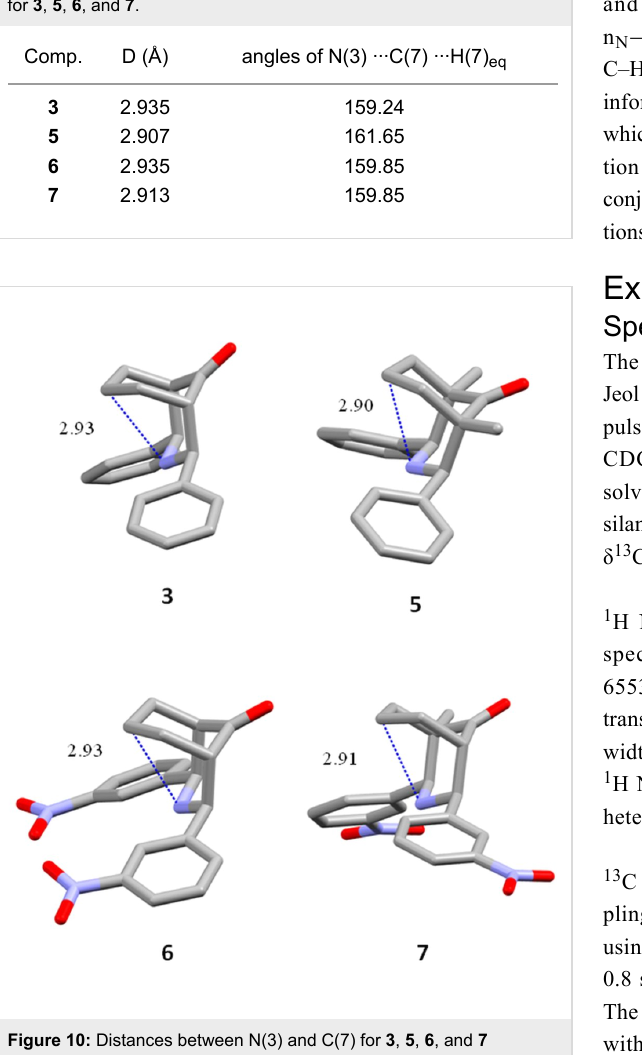
Figure 10: Distances between N(3) and C(7) for 3 , 5 , 6 , and 7 measured in the structures obtained by